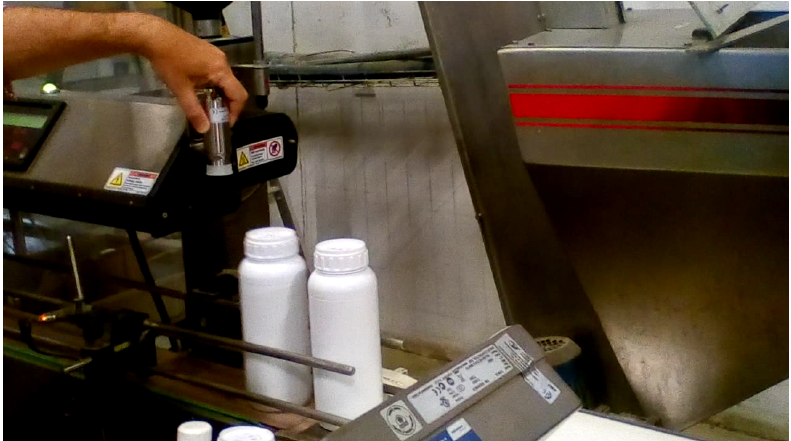
Figure 13. Picture taken in the production line during a stop. It shows two bottles right after they passed below the thermal camera. The human hand is adjusting the thermal